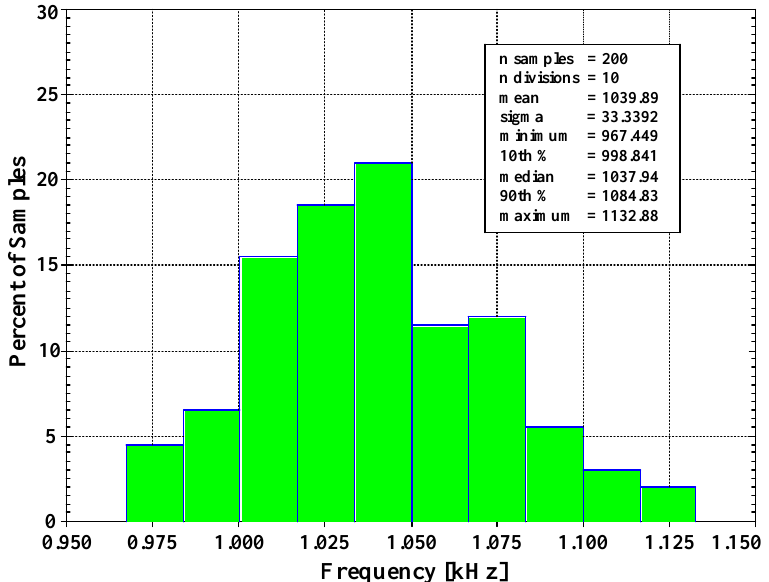
Figure 15. The histogram of the cutoff frequency of the universal filter with 200 runs of MC analysis.